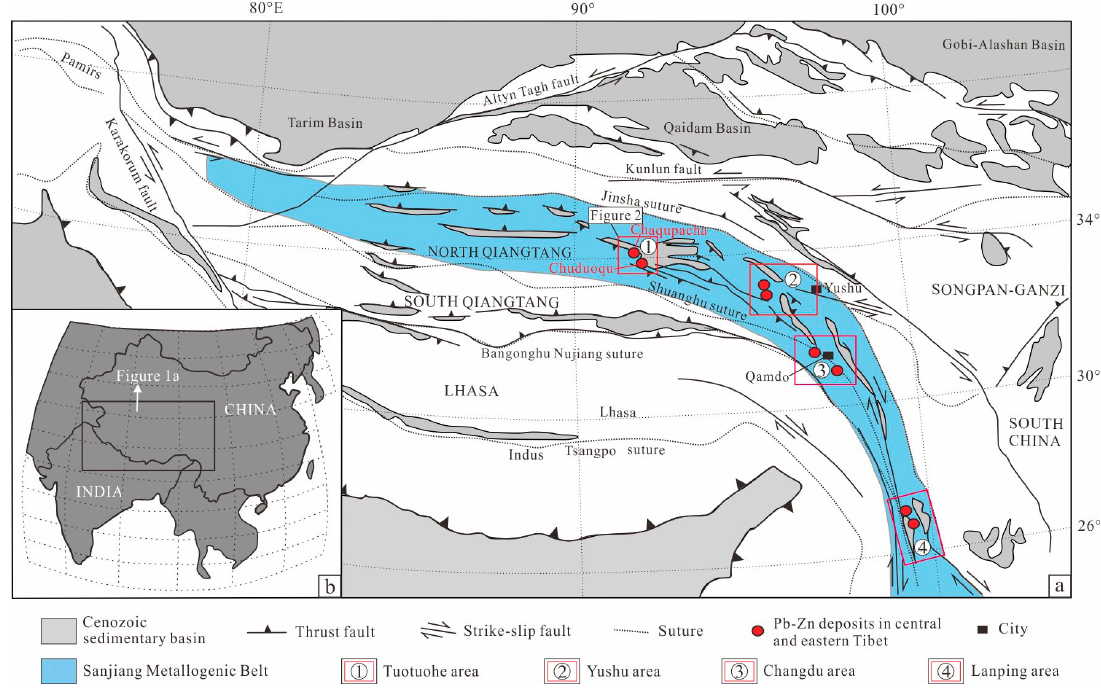
Figure 1. ( a ) Simplified geological map showing sutures, major structures, and Cenozoic basins in Tibet, modified after Spurlin et al. [4]. The map also shows the locations of the Chuduoqu deposit and other important Pb-Zn deposits in the Sanjiang Metallogenic Belt; ( b ) The inset map shows the location of Tibet within the eastern Asian continent, modified after Liu et al. [5].